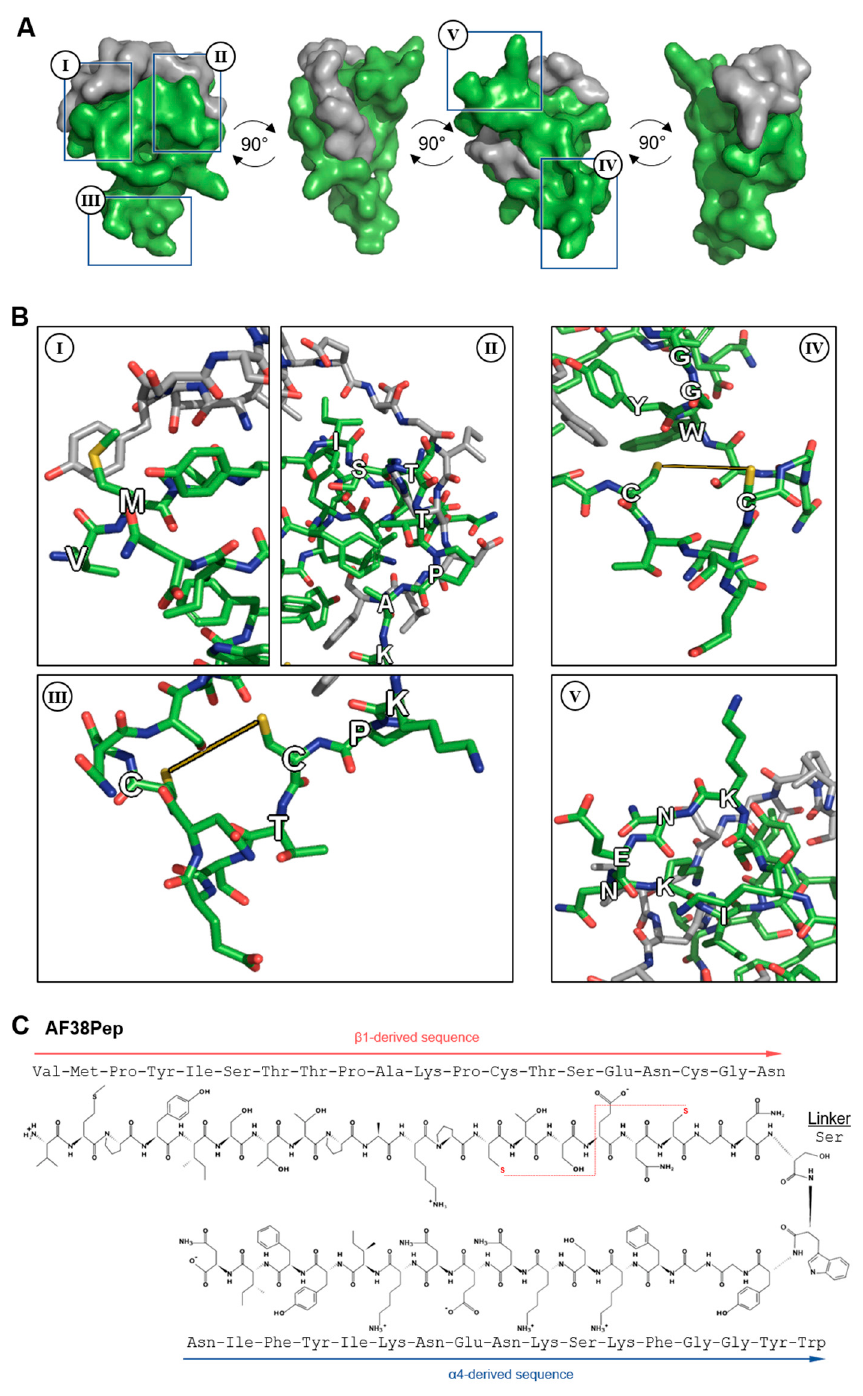
Figure 4. Molecular docking analysis of the designed blocking polypeptide and key features. ( A ) The EDA-FN peptide (grey) was docked to the blocking polypeptide (green) derived from the polypeptide with the overall highest scores across all refinement analyses. A 360° rotation is shown to visualize the wrapping and binding of the EDA-FN peptide to the blocking polypeptide, which mimics the integrin α 4 β 1 / β 7 receptor binding site. Boxed regions I–IV are shown in ( B ) to highlight the key features of the designed blocking polypeptide. I, the VM cap; II, the ISTTPAK motif of the β 1 / β 7 subunit; III and IV, the C=C disulfide bridge to form the receptor and cage-like conformation; V, the KNENKI motif of the α 4 subunit. ( C ) The antifibrotic 38-amino-acid polypeptide (AF38Pep) polypeptide sequence structure, showing two peptide chains derived from integrins β 1 and α 4 , linked by a serine. Disulfide bridge is shown by a red dashed line, bridging the two cysteines.